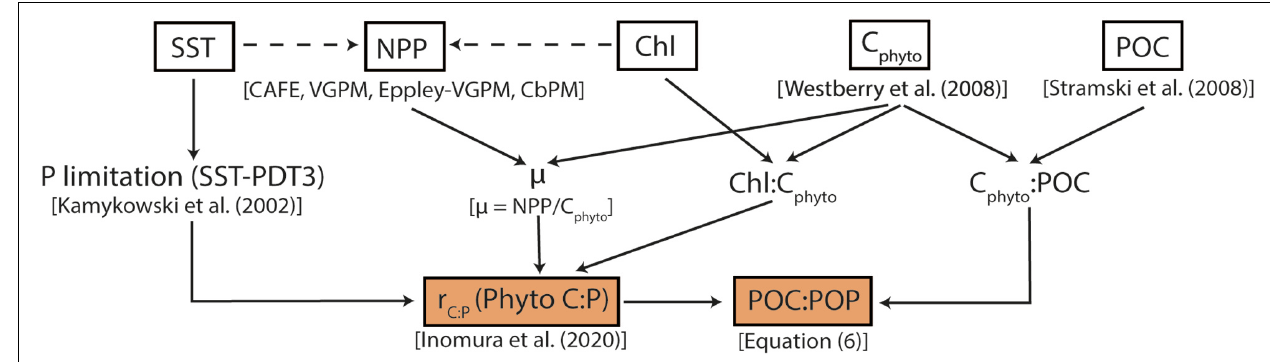
FIGURE 1 | Flowchart summarizing the modeling framework. White squares represent globally gridded data from MODIS- Aqua and their direct products (NPP, C phyto , and POC). The dashed arrows pointing toward NPP indicate that remotely sensed SST and Chl are used in deriving NPP. Orange boxes are main products from this study; C:P of phytoplankton ( r C : P ) and bulk